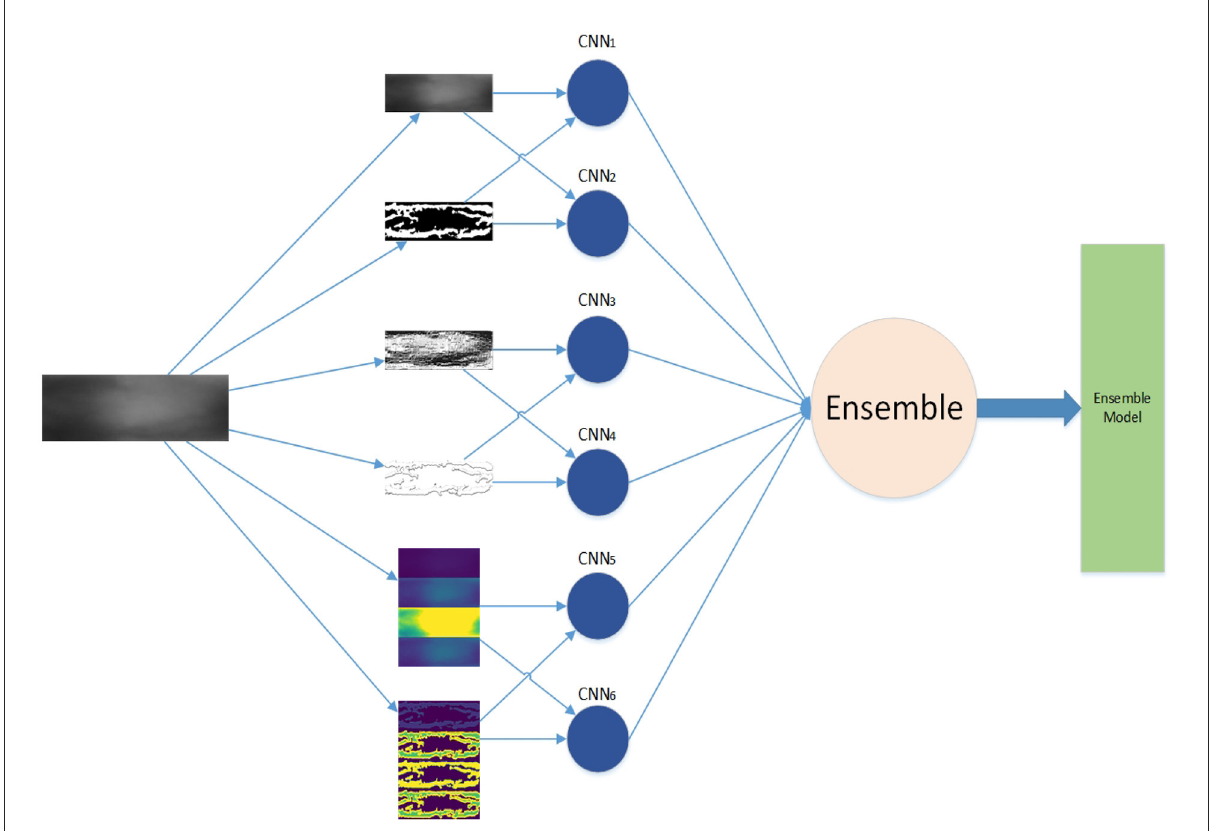
FIGURE9 Training structure of the shared learning